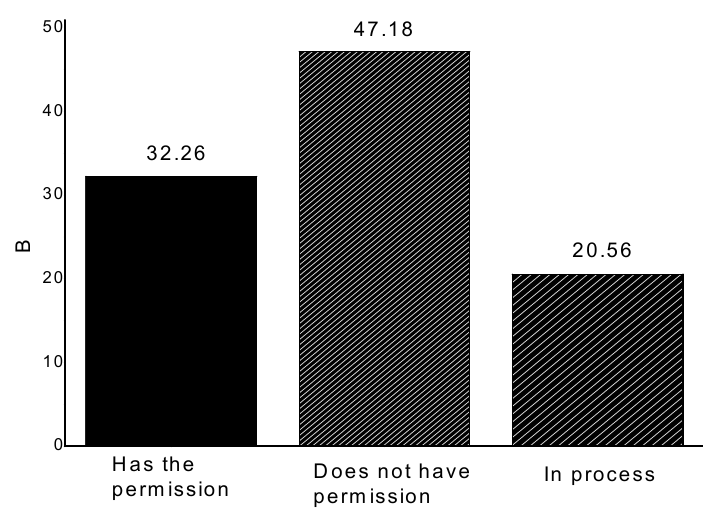
Figure 7. Aquaculture producers surveyed in Mexico. Percentage of wastewater discharge authorizations (2019).